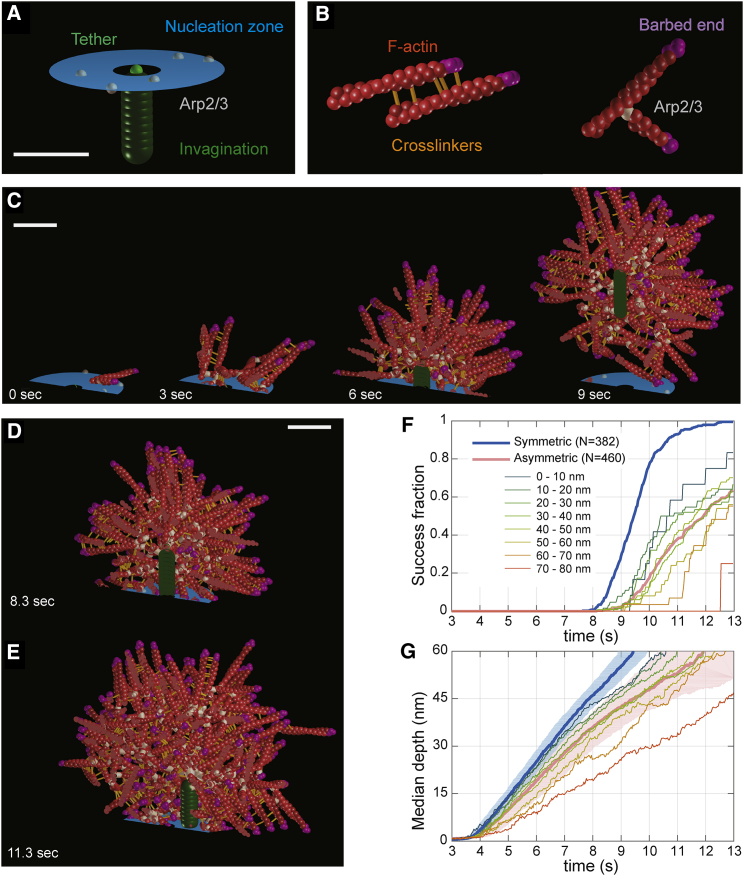
Simulations of the Actin Network at Endocytic Sites Using Cytosim(A and B) Initial configuration of the simulation (A) and overview of simulated elements (B).(C) Time series of a representative simulated endocytic event, with a snap-through transition at ∼9 s.(D) Detail of an endocytic event where nucleation occurred all around the invagination. 5,022 actin monomers were required to reach the snap-through transition. Lateral distance between actin center of mass and invagination is 7 nm. See also Video S1.(E) Detail of an endocytic event where actin nucleation occurred asymmetrically with respect to the invagination, shown at the same depth as (D). More time and actin (7,824 monomers) were required to reach the snap-through transition. Actin is not symmetrically organized, with a lateral distance of 32 nm between actin center of mass and invagination.(F) Fraction of successful simulations that overcome the snap-through transition over time, for symmetric (blue) and asymmetric nucleation (red). N is number of simulations. Thin lines correspond to different distances between tether and center of actin nucleation (bin width, 10 nm) at the starting time of invagination.(G) Median invagination depth over time for symmetric (blue) and asymmetric nucleation (red). Color-filled areas represent the spread from the first to third quartile. Thin lines show median invagination depths over time within the same bins as (F).Scale bars represent 50 nm.See also Figure S7 and Videos S2 and S3.